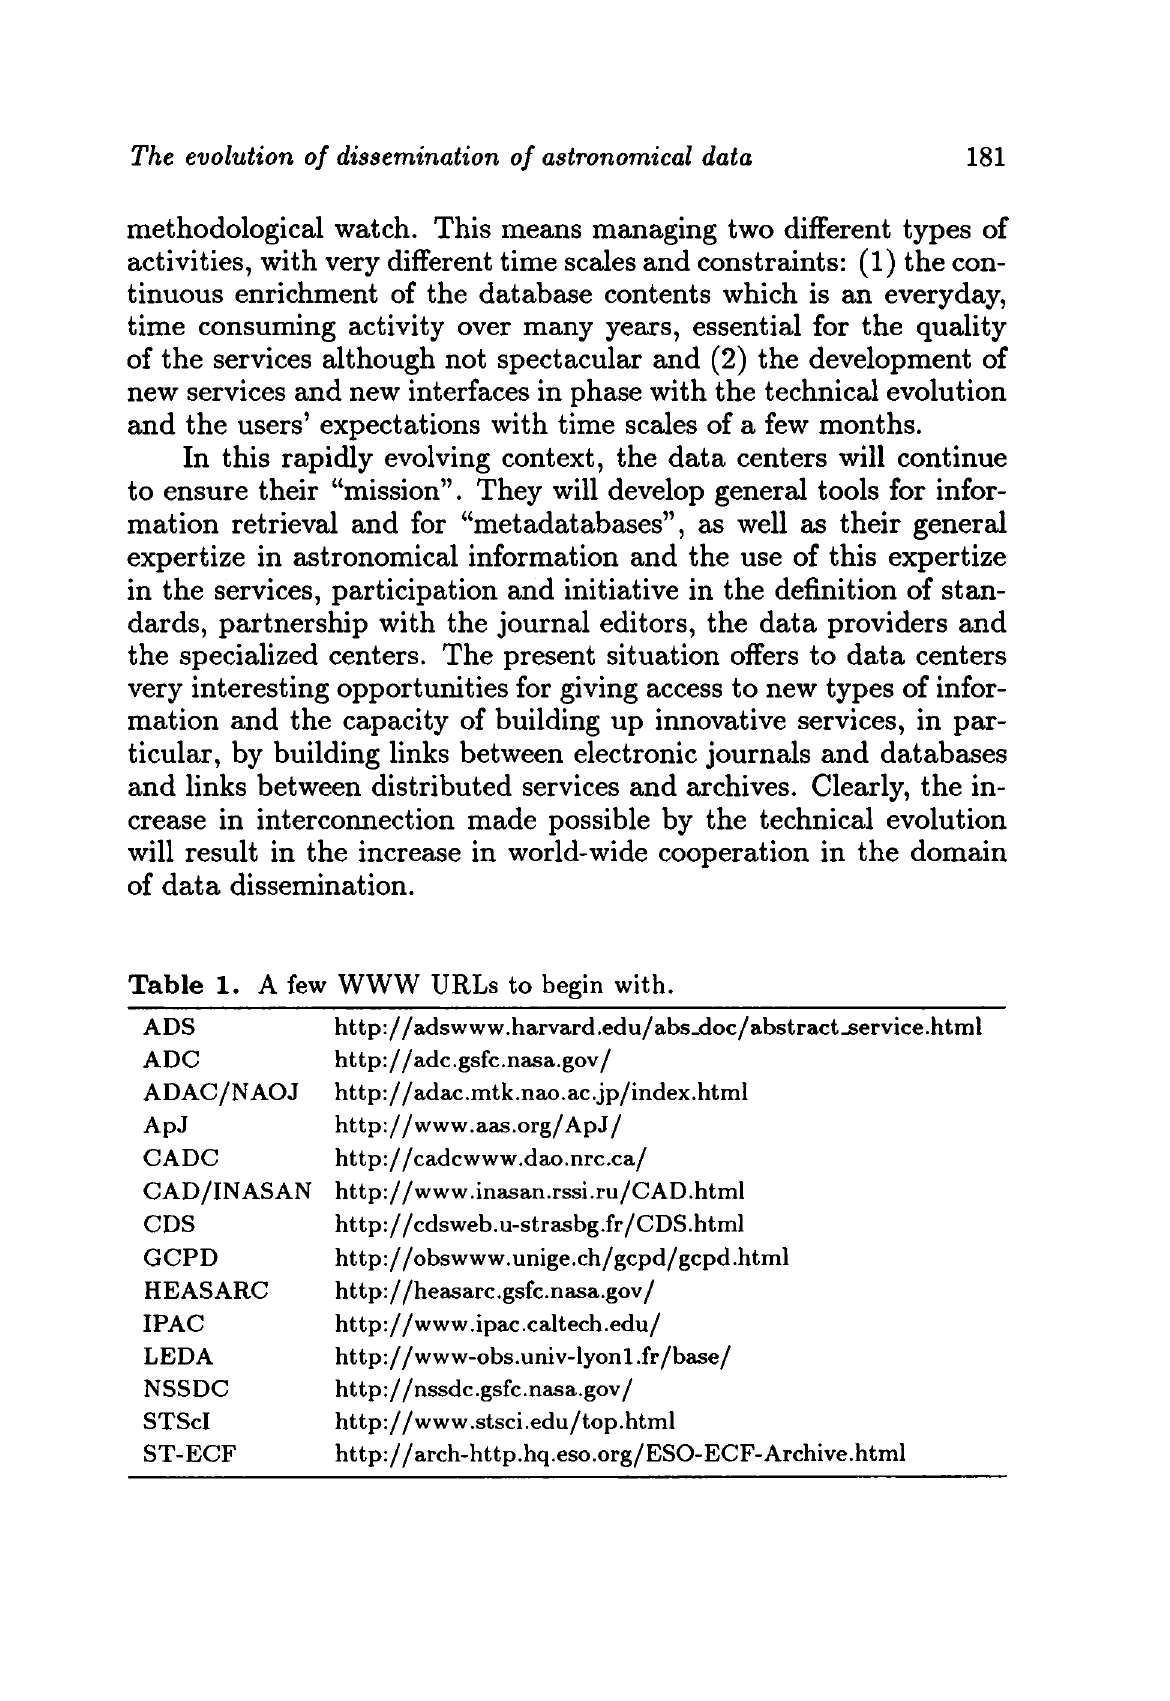
Table 1. A few WWW URLs to begin